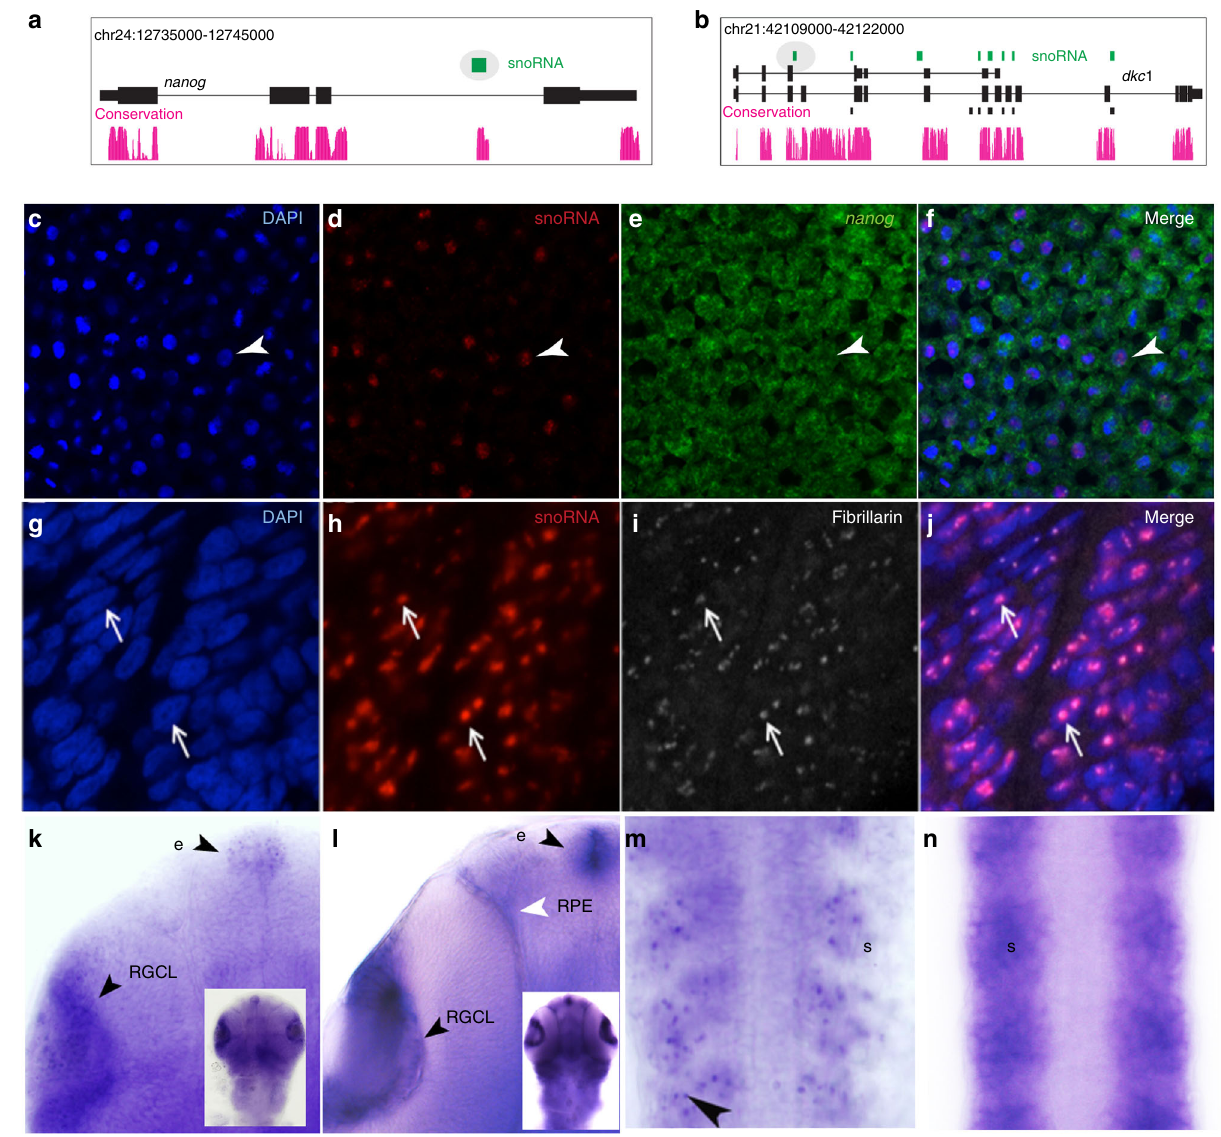
Fig. 5 Localization of snoRNAs and host mRNA products in the embryo. a , b A UCSC browser showing annotated snoRNAs (green) in the introns of nanog and dyskerin ( dkc1 ). Ensembl annotated genes and snoRNAs are shown as black tracks. Teleost sequence conservation tracks are shown in magenta. Two snoRNAs selected for expression analysis are highlighted in oval. c – e In situ hybridization in whole mount zebra fi sh embryos at the 30% epiboly stage with probes detecting nuclei ( c ), snoRNA gene embedded in nanog ( d ) nanog coding exon ( e ), and overlay ( f ). ARrowheads indicate overlapping spots. g – j In situ hybridization with snoRNA probe ( h ) for the dyskerin gene is detected in the nucleoli of somitic nuclei detected by DAPI ( g ), and indicated by immunohistochemical detection of fi brallin ( i and overlay in j ). Arrows indicate the same spots in the overlapping frames. k – n In situ hybridization probes detect dyskerin and embedded snoRNA gene activities in long-pec stage embryos. k , m snoRNA probe detects expression in epiphysis (arrowhead with e ), retinal ganglion cell layer (arrowhead with RGLC) and the somites (arrowhead in m ). l , n Exon probe for dyskerin indicates cytoplasmic expression in the epiphysis (arrowhead and e ), retinal ganglion cell layer (arrowhead RGCL), and retinal-pigmented epithelium (white arrowhead and RPE) and the somites (s, black arrowhead in n ). Inserts in k and l show dorsal views of heads, from which the magni fi ed views are